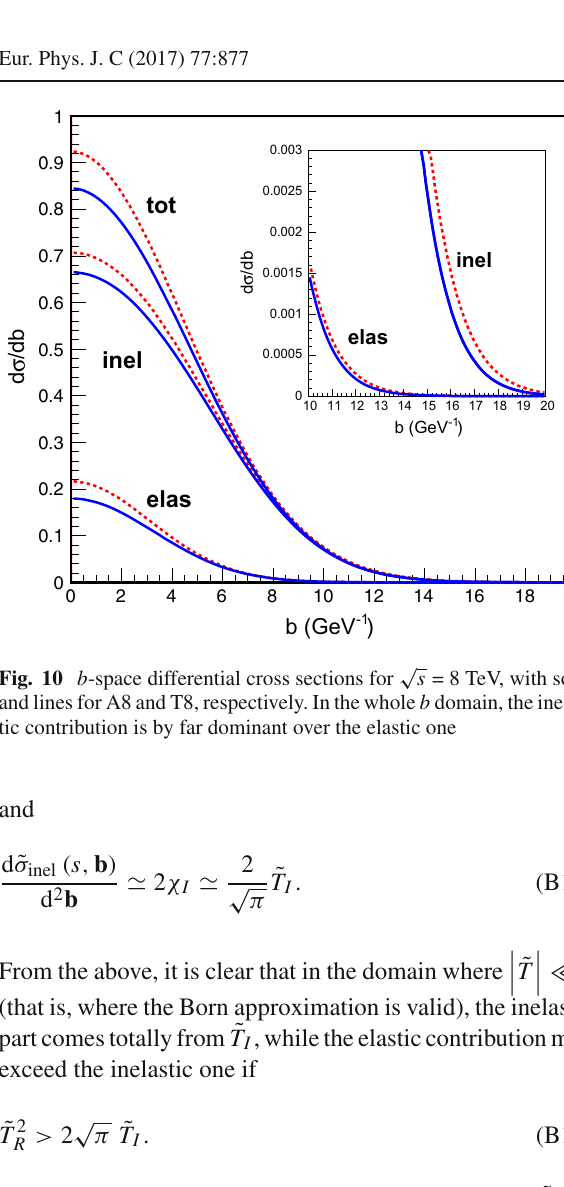
Fig. 10 b -space differential cross sections for and lines for A8 and T8, respectively. In the whole b domain, the inelas- tic contribution is by far dominant over the elastic one